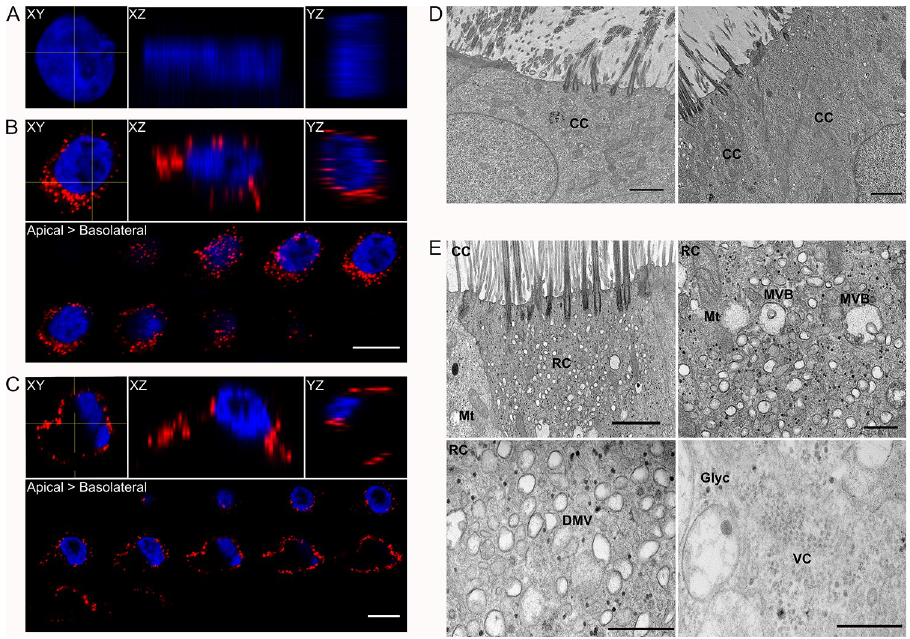
Fig 2. Detection of RV-C15 replication complexes in HAE. A-C: Orthogonal views (XY, XZ and YZ planes; yellow lines show the location of XZ and YZ views on the XY plane) from non-infected (A) and RV-C15-infected ( B-C ) cells immunostained for dsRNA (red) and nuclei (blue) at 12hpi (z-stacks at 1 μ m of thickness; scale bar = 10 μ m). B-C : Z- stacks (1 μ m of thickness) from RV-C15-infected HAE show dsRNA (red) detection by immunofluorescence with perinuclear (B ) or ring-like disposition close to the plasma membrane ( C ). D-E: TEM of non-infected ( D ) and RV-C15-infected ( E) HAE fixed at 12hpi. D: Visualization of ciliated cells (CC ) in non-infected HAE ( D– left panel) occasionally revealed small vesicles spread through the cytoplasm ( D– right panel ) (scale bar = 2 μ m). E: Larger vesicles were detected in ciliated cells ( CC ) from RV-C15-infected HAE that resembled replicative complexes ( RC ; E –upper-left panel ; scale bar = 5 μ m) observed during RV-A and RV-B infection [30]. These vesicles were detected in close proximity to mitochondria ( Mt ) and multi-vesicular bodies ( MVB ; E –upper-right panel ; scale bar = 2 μ m), and were found to have double-membranes (DMV; E –lower-left panel ; scale bar = 0.5 μ m). Clusters of electron-dense structures in the cytoplasm of RV-C15-infected HAE were seen, reminiscent of viral crystals (VC; E –lower-right panel ; scale bar = 0.5 μ m) described for other picornaviruses [32,33].Glyc =